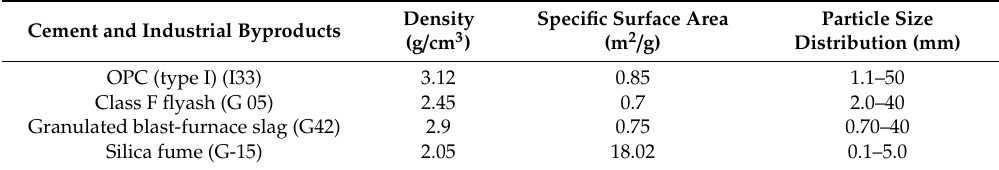
Table 1. Particle size distribution, Specific surface area and density data of cement and industrial byproducts [8].